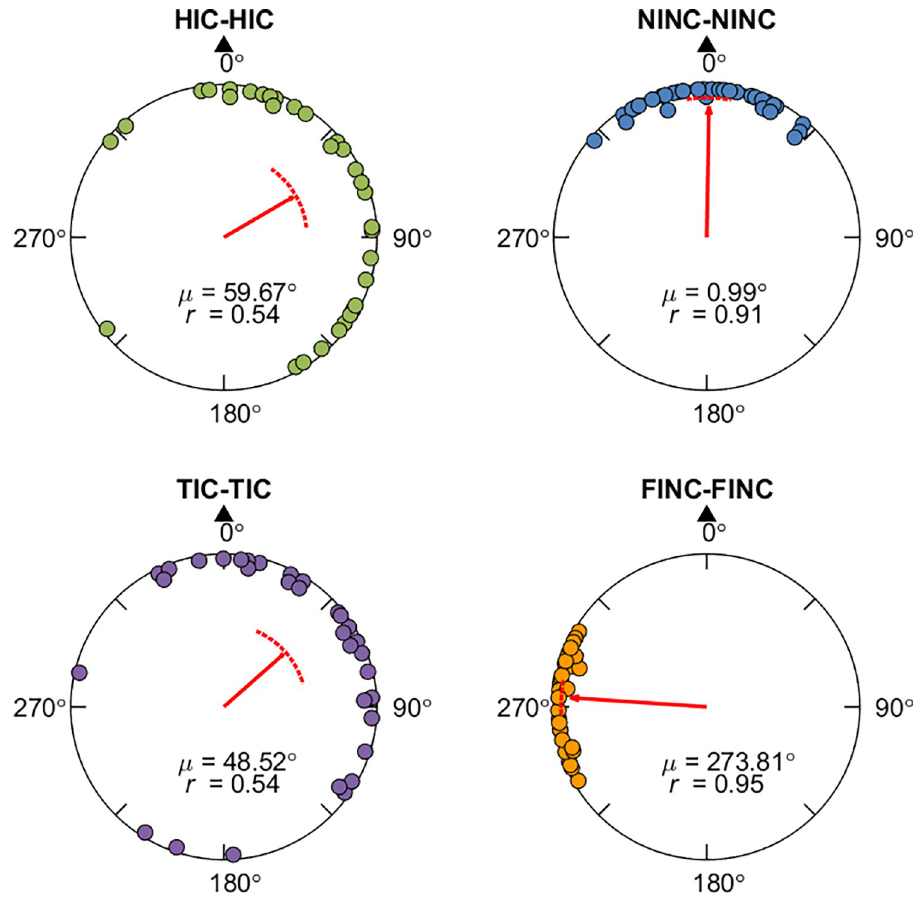
Fig 10. Mean pointing error (AE G ) across paths for each condition in Experiment 2 with only the trials primed by the same condition. HIC-HIC: HI-C to HI-C condition only. NINC-NINC: NI-NC to NI-NC condition only. TIC-TIC: TI-C to TI-C condition only. FINC-FINC: FI-NC to FI-NC condition only. Abbreviations and legend are the same as in Fig 3.